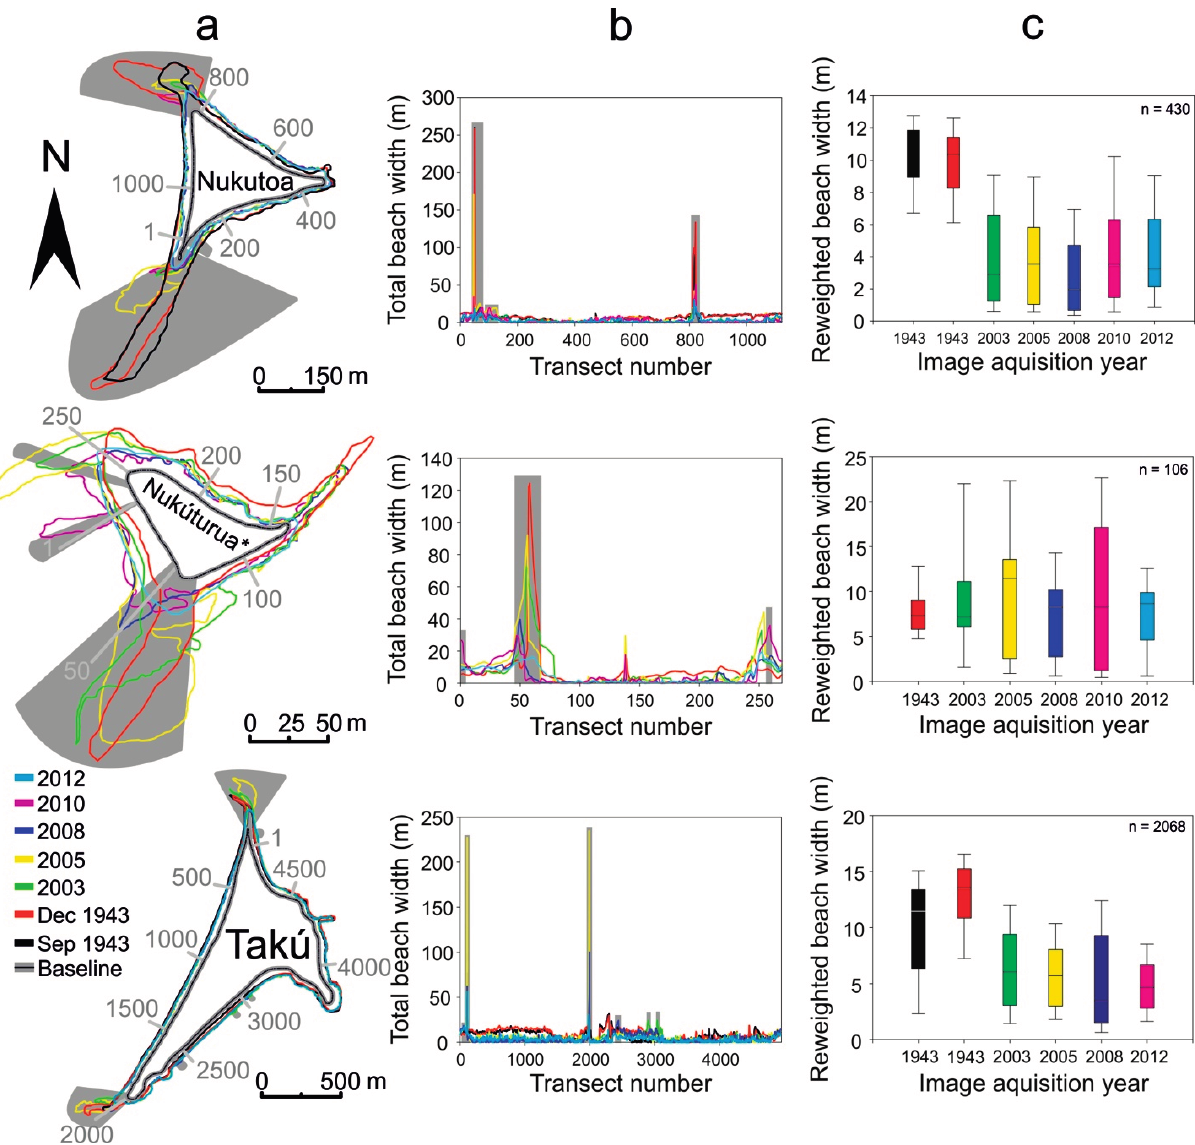
Figure 11. ( a ) Illustration of superposed toe of beach positions for Nukutoa, Nukúturua (* = western part) and Takú. Selected transects are marked in light grey to indicate their position on the map ( b ) Changes in total beach width as a function of Shoreline Change Envelope. Dark grey backgrounds in a and b display the range of transects that comprised extreme high SCE values. ( c ) Box plots showing the 10th, 25th, 50th, 75th and 90th percentiles of reweighted beach width. n = number of